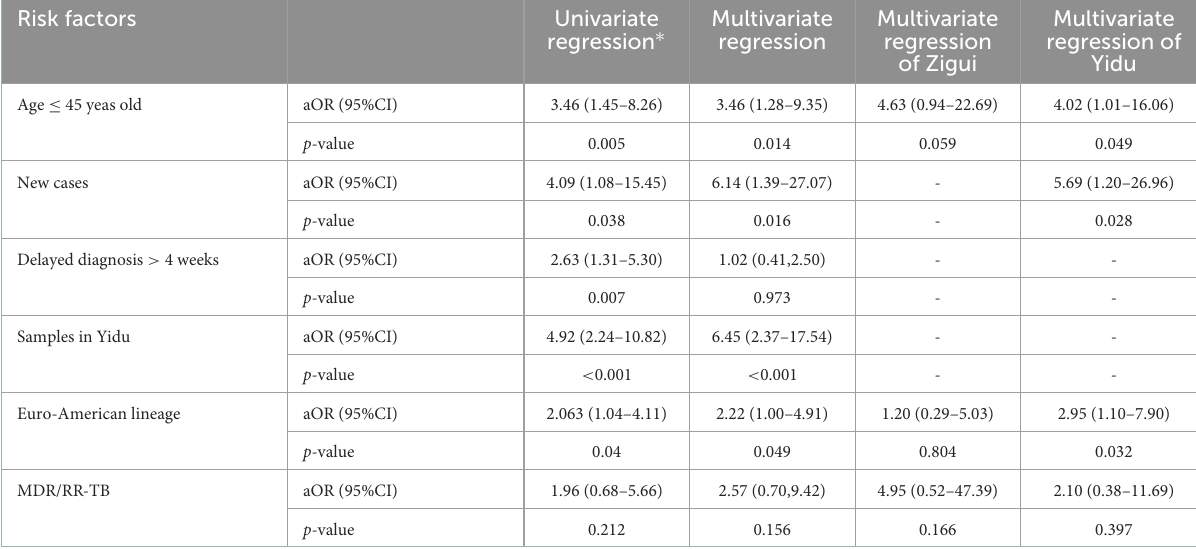
TABLE 4 Hierarchical multivariable logistic regression of risk factors for tuberculous transmission clusters.